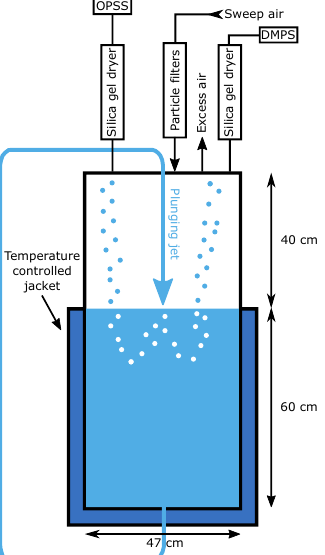
Figure 1. Schematic of the plunging jet tank used for the experi-